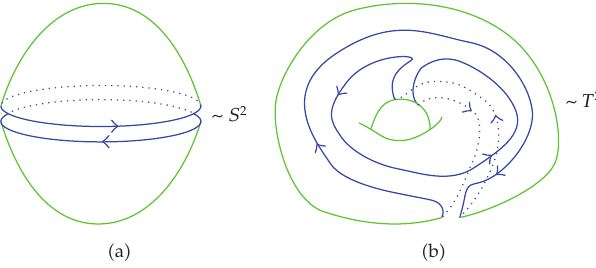
Figure 5: Direct surfaces constructed from the vacuum diagram in (cid:2) a (cid:3) Figure 3 (cid:2) a (cid:3) and (cid:2) b (cid:3) Figure 4.